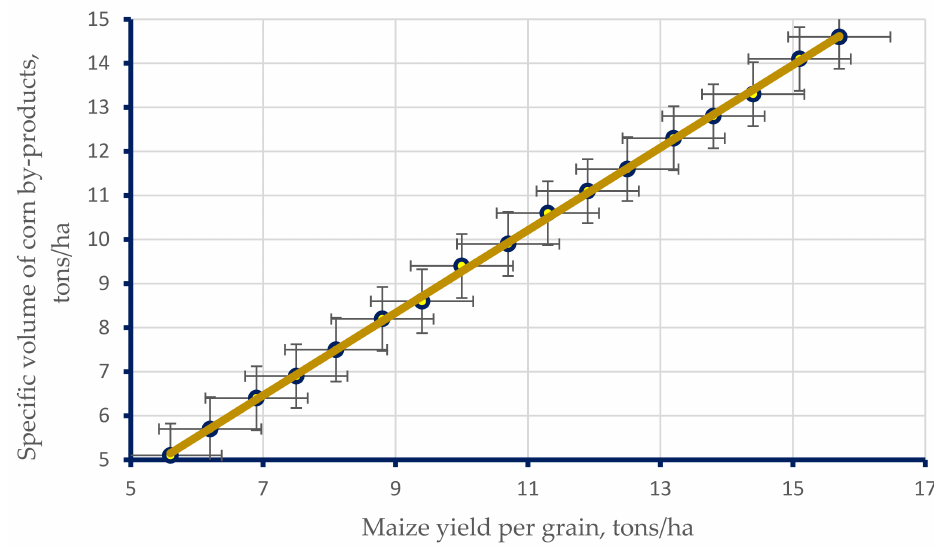
Figure 3. Dependence of the specific volume of by-products of corn on its yield.